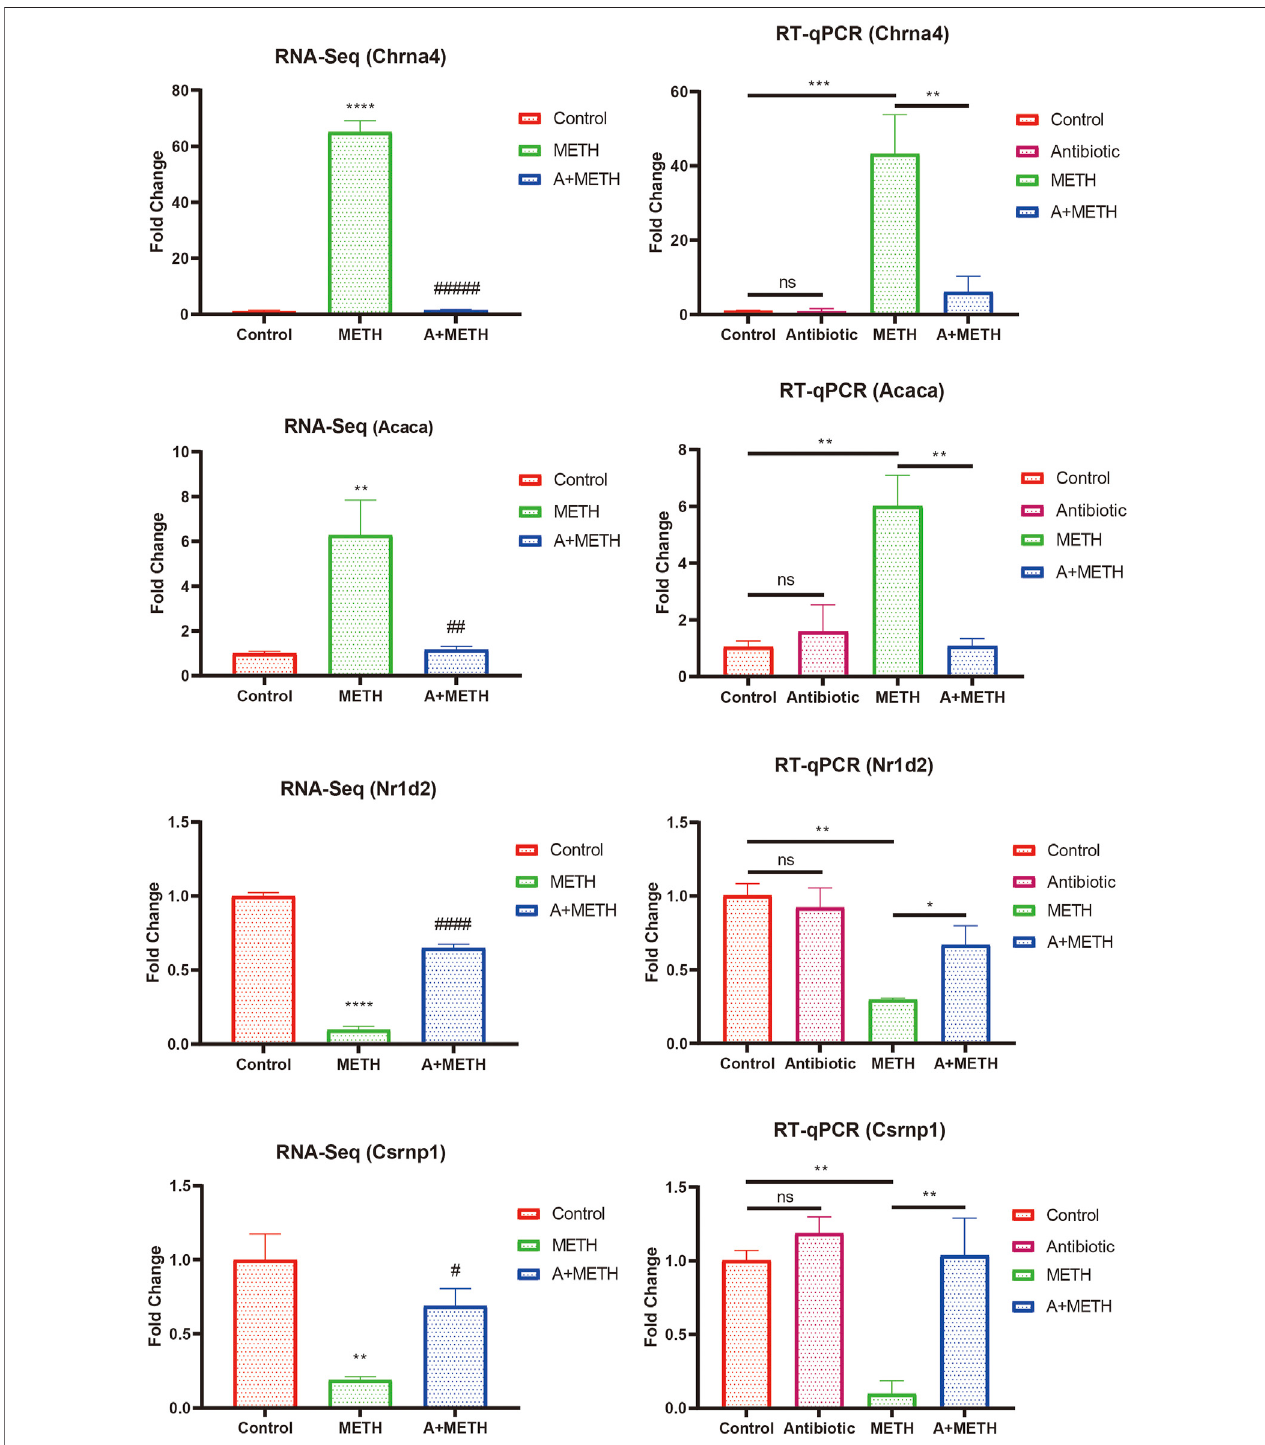
FIGURE7| ConsistencyofRNA-seqandRT-qPCRresults.RT-qPCRresultsofselectedDEGs(Chrna4,Acaca,Nr1d2,andCsrnp1)wereconsistentwiththoseof RNA-seq. RNA-seq: * p < 0.05, ** p < 0.01, *** p < 0.001,signi fi cantly different compared tothecontrolgroup; # p < 0.05, ## p < 0.01, ### p < 0.001, signi fi cantlydifferent compared to the METH group. RT-qPCR: * p < 0.05, ** p < 0.01, *** p < 0.001, ns, statistically non-signi fi cant.